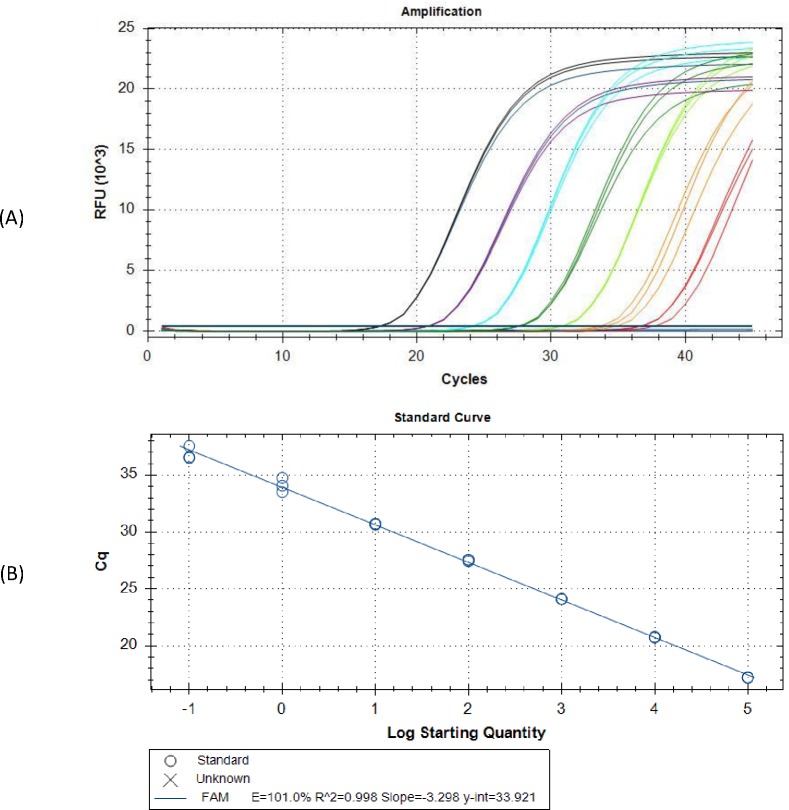
Technical performance and range of detection of the Leishmania real-time PCR assay.In (A) DNA was extracted from serial dilutions of cultured L. donovani, ranging from 1 x 105 to 1x 10−1/ ml, and subjected to real time PCR. Amplification curves are shown for each sample, with each parasite concentration depicted by a differing color. In (B) the mean Ct values are plotted from triplicates tested against serial dilutions containing 10ng to 10fg of L.donovani genomic DNA per reaction. Each point represents the Ct of an individual sample, with the plot of Ct values and parasite equivalent fitting a linear function (R2 _0.998).